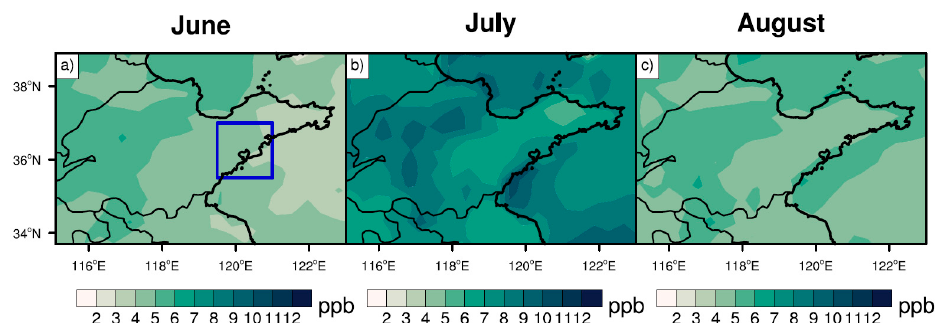
Figure 6. Monthly MDA8 ozone concentrations (units: ppb) over Shandong Province in ( a ) June, ( b ) July, and ( c ) August during 2014–2019, caused by biogenic emissions. The blue box in Figure 6a denotes Qingdao.